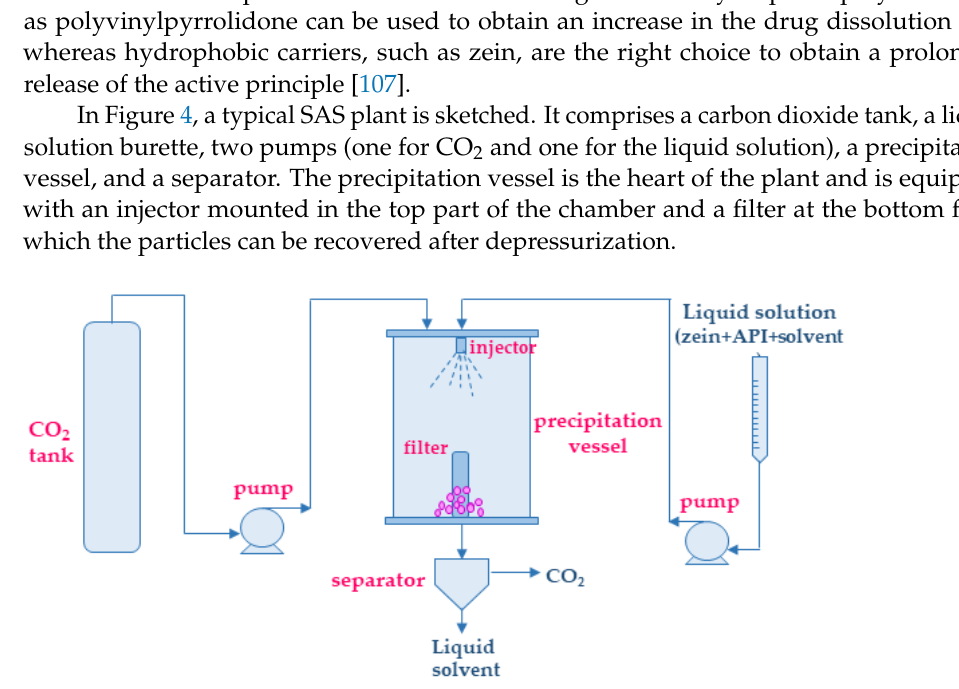
Figure 4. Sketch of a typical supercritical antisolvent precipitation plant.